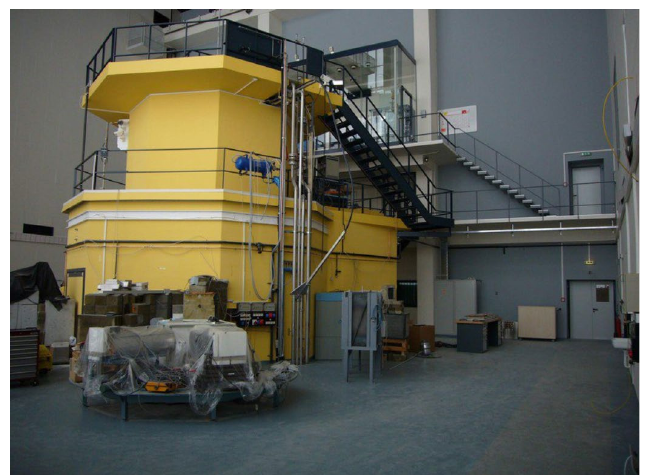
Fig. 4 . TRIGA Mark II reactor, TUWien, Vienna.